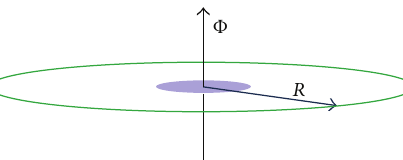
Figure 1: A one-dimensional ring of radius 𝑅 threaded by a magnetic flux Φ . The field is finite only within the shaded region.